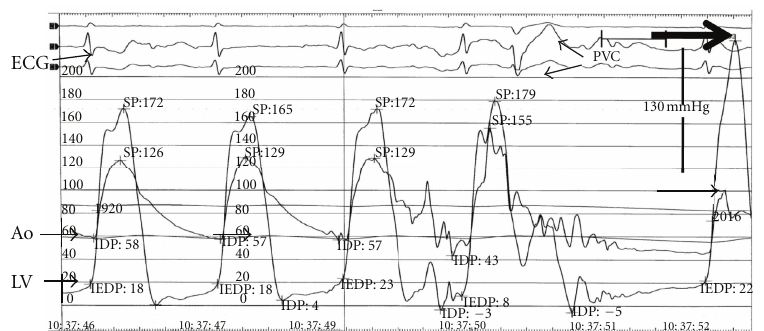
Figure 5: Pressure tracings show a sharp rise in LV outflow gradient that follows the pause associated with PVC. A dynamic obstruction leads to a concomitant fall in aortic pressure and a disproportionate (46 to 130 mmHg) increase in gradient. This phenomenon, known as the Brockenbrough-Braunwald-Morrow sign, is part of the classical description of hypertrophic obstructive cardiomyopathy. Ao: aorta; ECG: electrocardiogram; LV: left ventricle; PVC: premature ventricular